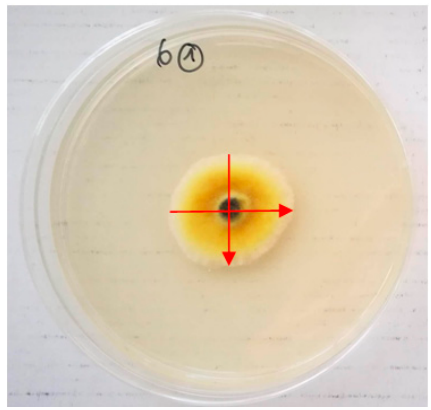
Figure 3. The measurement of the diameter of Alternaria spp. mycelium growth. The mean of colony growth diameters (cm) used for radial colony growth rate (cm/day) calculations [39]: Cr —radial colony growth rate, cm/day; r —mean of colony diameters, cm; t —growth duration,